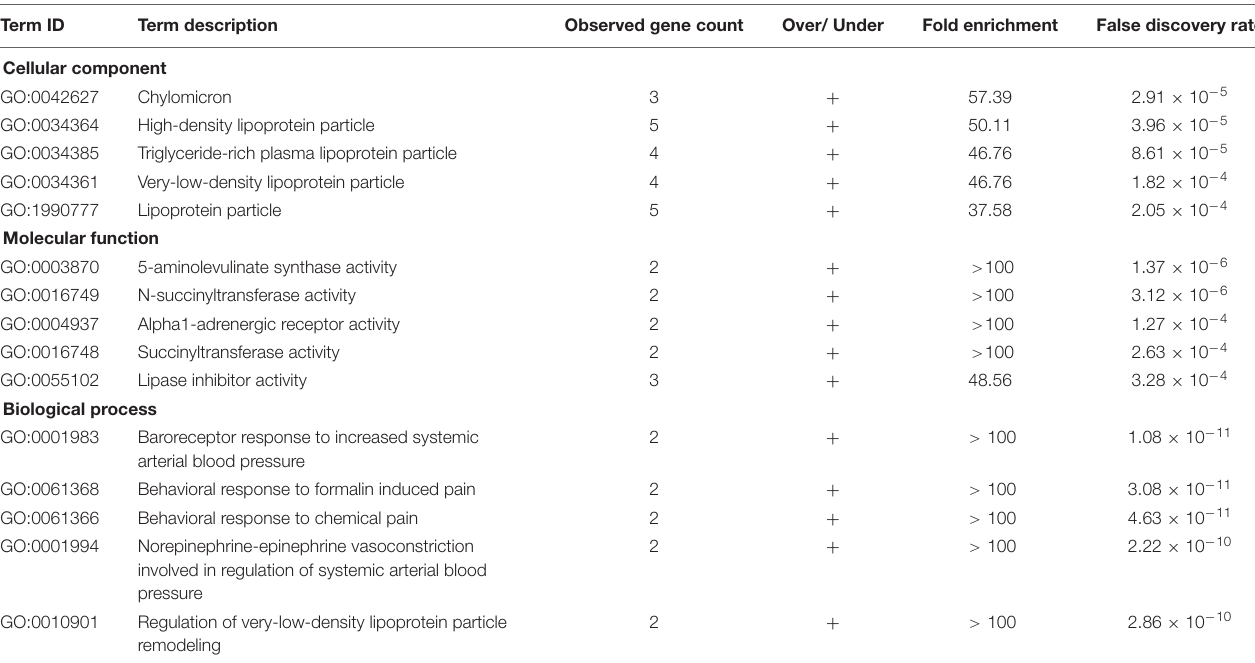
FIGURE 1 | Volcano plot and heatmap of differential genes between Acarbose and Water. (A) All 6084 differential genes were utilized for volcano plot. Red: significantly up-regulated in Acarbose; blue: significantly down-regulated in Acarbose; yellow: no significant change. (B) The top 150 most significantly up-regulated and 150 most significantly down-regulated genes were utilized for heatmap presentation. Red, up-regulated genes in Acarbose; blue, down-regulated genes in Acarbose. Samples showed distinct gene expression patterns between the two groups, but comparable expression patterns within a group. TABLE 1 | Enriched GO pathways in Acarbose compared to